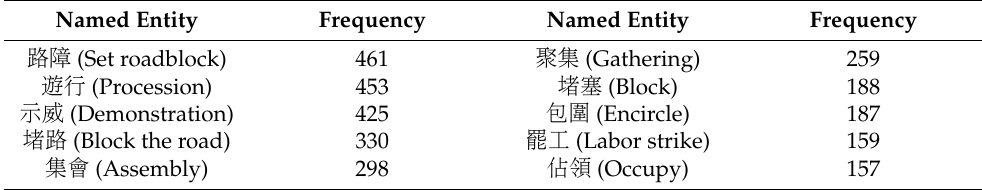
Table 3. Some action entities with relatively high